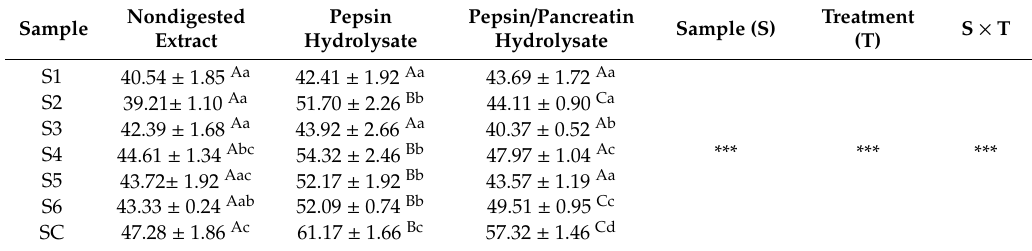
Table 7. Results of angiotensin-converting enzyme (ACE-I) inhibiting activity